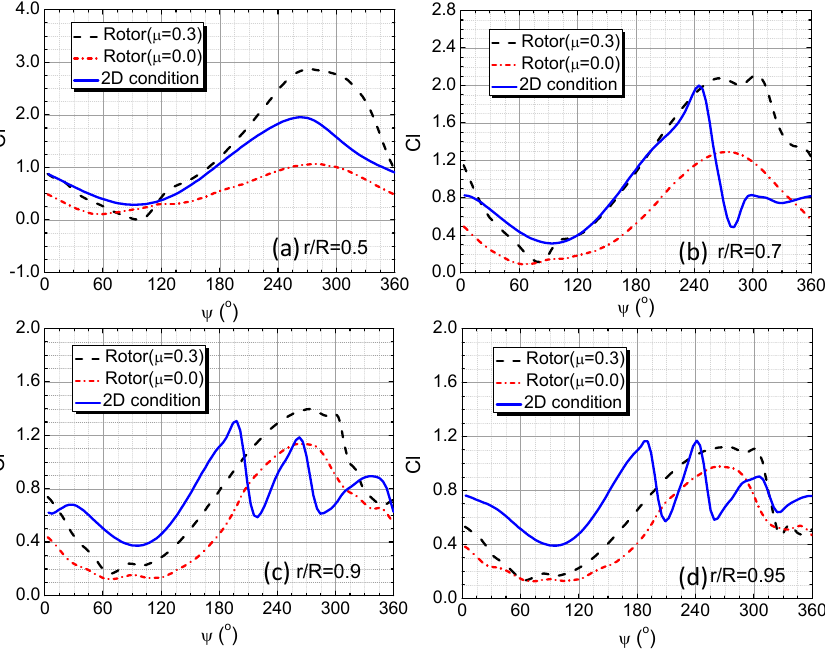
Figure 16. Lift coefficients vary with azimuth at different blade sections. ( a ) r/R = 0.5, ( b ) r/R = 0.7, ( c ) r/R = 0.9, ( d ) r/R = 0.95.